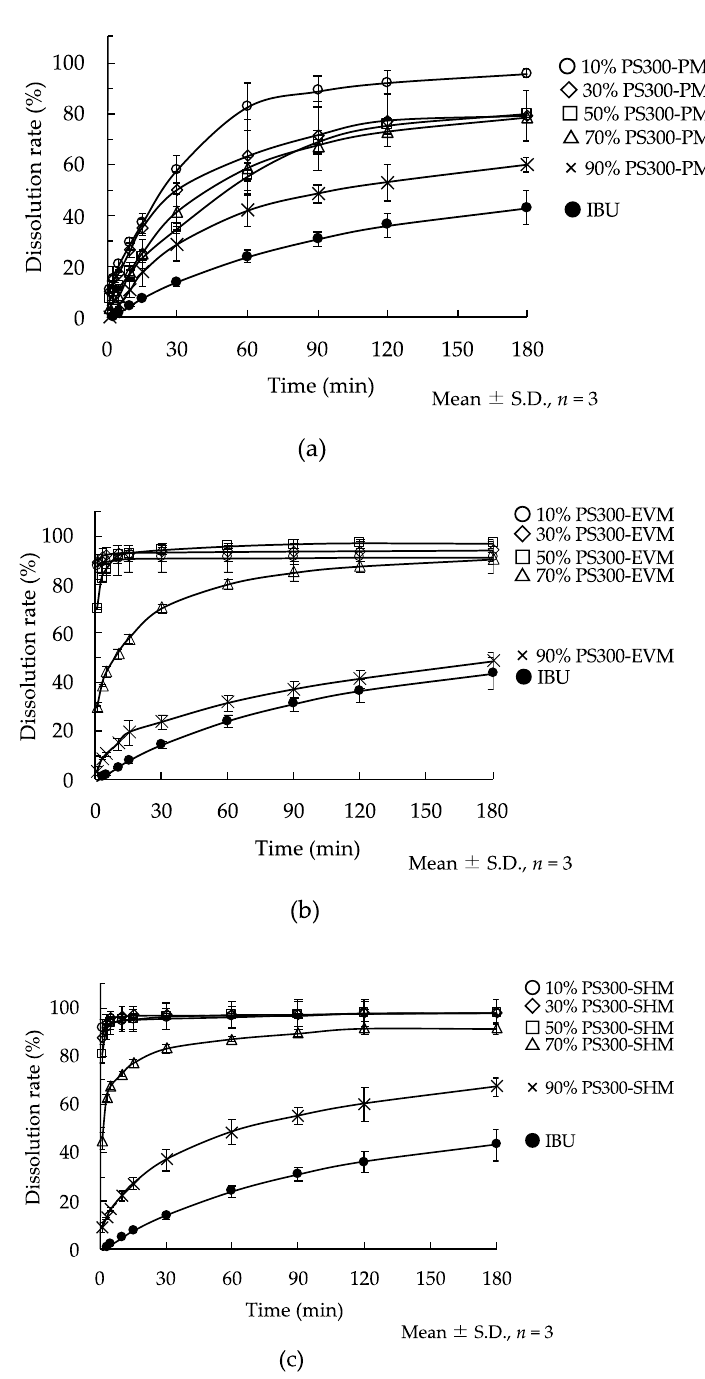
Figure 8. Dissolution behavior of IBU from IBU crystals and various samples. ( a ) PM: ● : IBU crys-